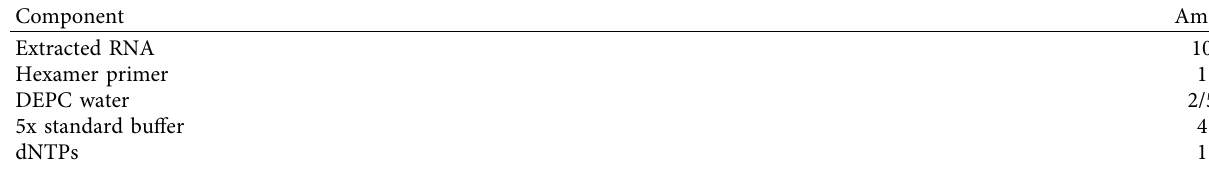
Table 2: cDNA synthesis kit manufacture.